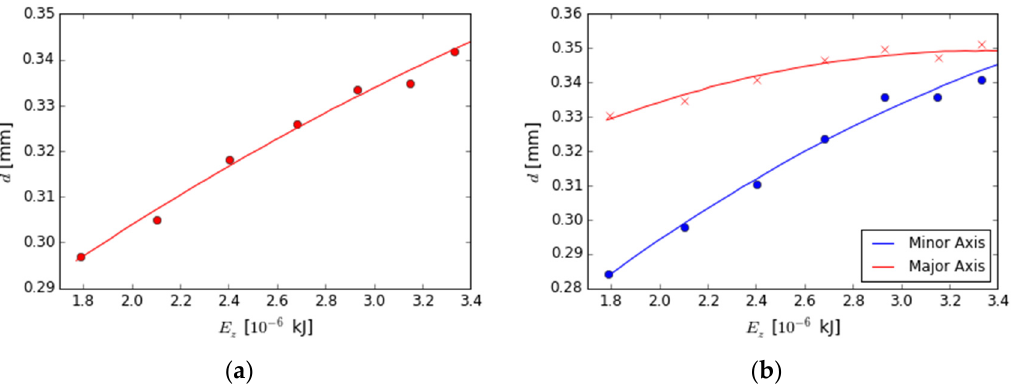
Figure 3. The variation of the dimple diameter as a function of the vertical component of the shot kinetic energy ( a ) perpendicular impact; ( b ) oblique impact (shot diameter = 0.6 mm, shot velocity = 60 mm s − 1 ).